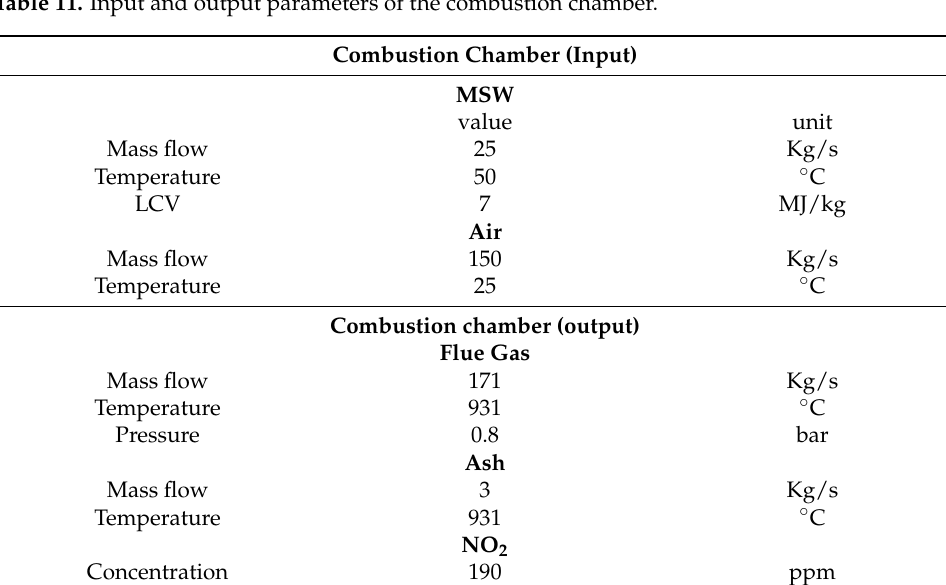
Figure 7. Simulated selective non-catalytic reduction (SNCR) technology for NO x emissions in Ebsilon (190 ppm = 357.5 mg/Nm 3 ). Table 11. Input and output parameters of the combustion